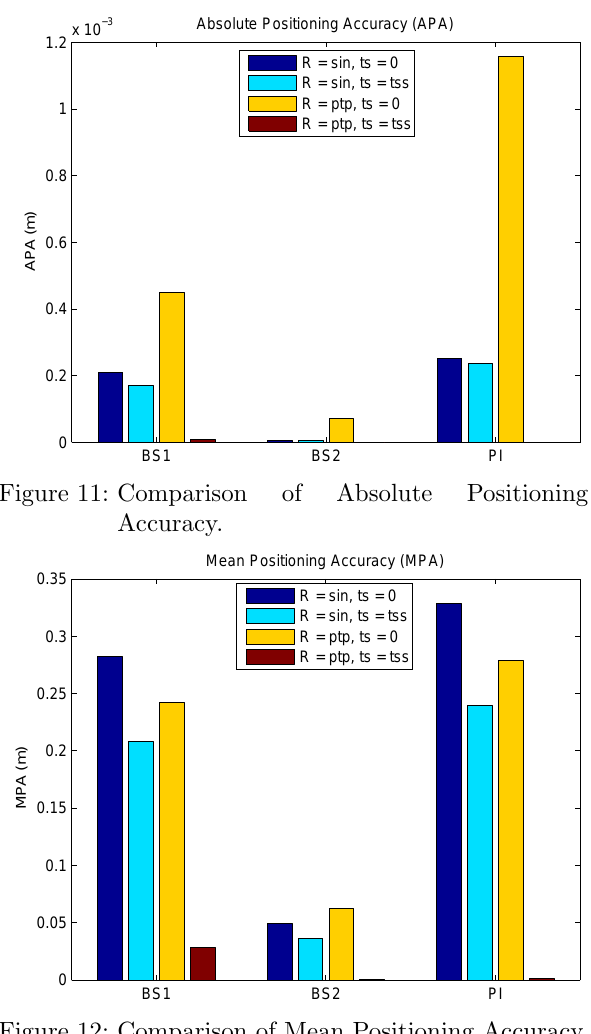
Figure 12: Comparison of Mean Positioning Accuracy.